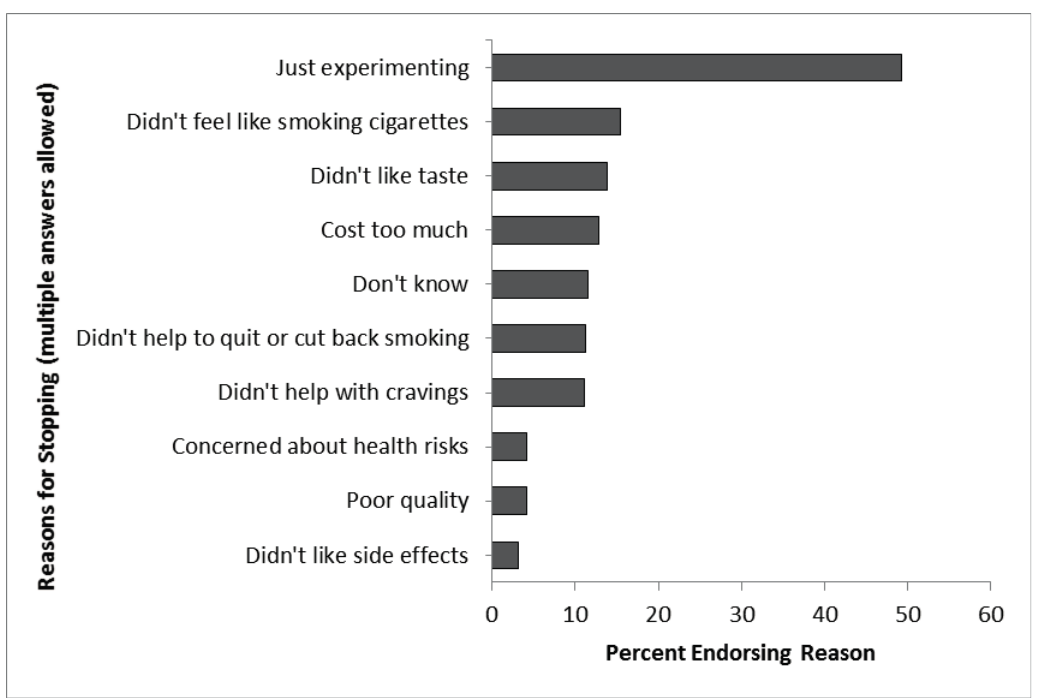
Figure 2. Reasons for stopping e-cigarette use ( n =